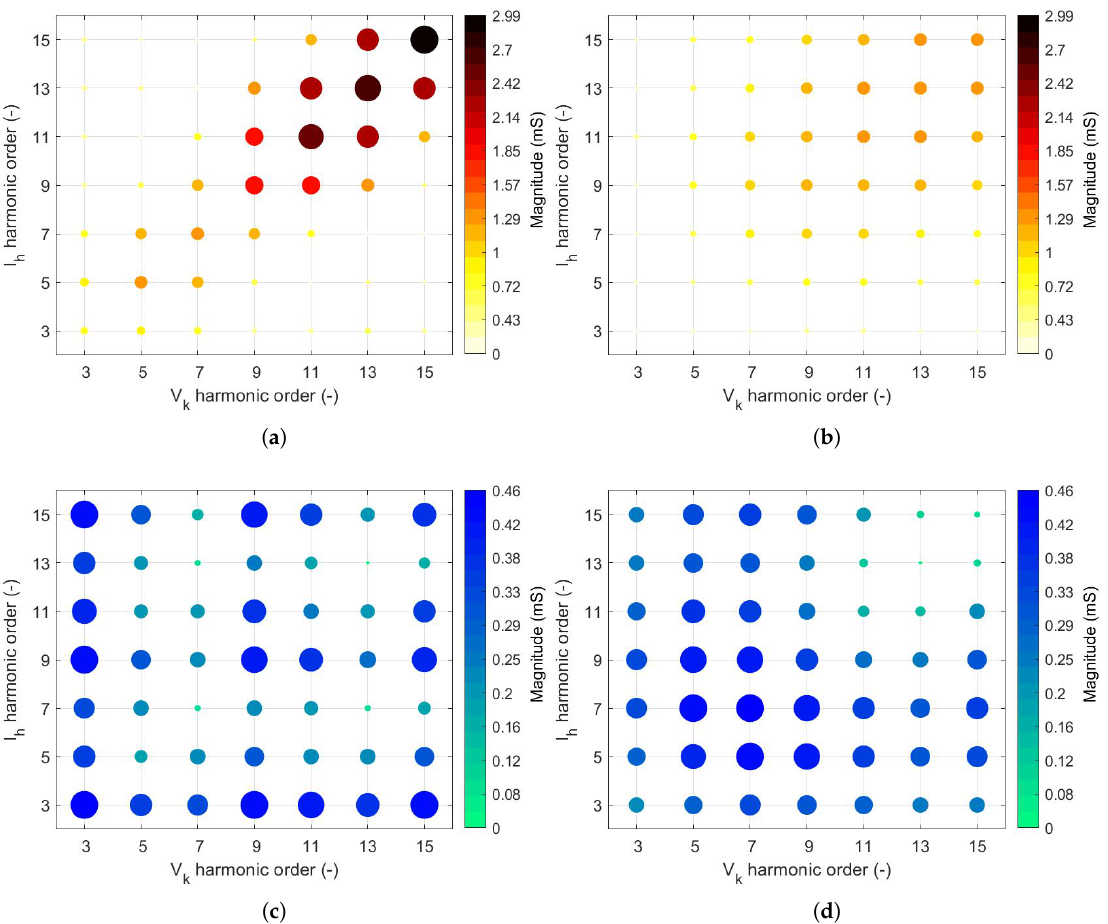
Figure 11. Magnitude of frequency coupling matrices of the Type A LED lamp: ( a ) Y + FT; ( b ) Y + PT; ( c ) Y − FT; and ( d ) Y −